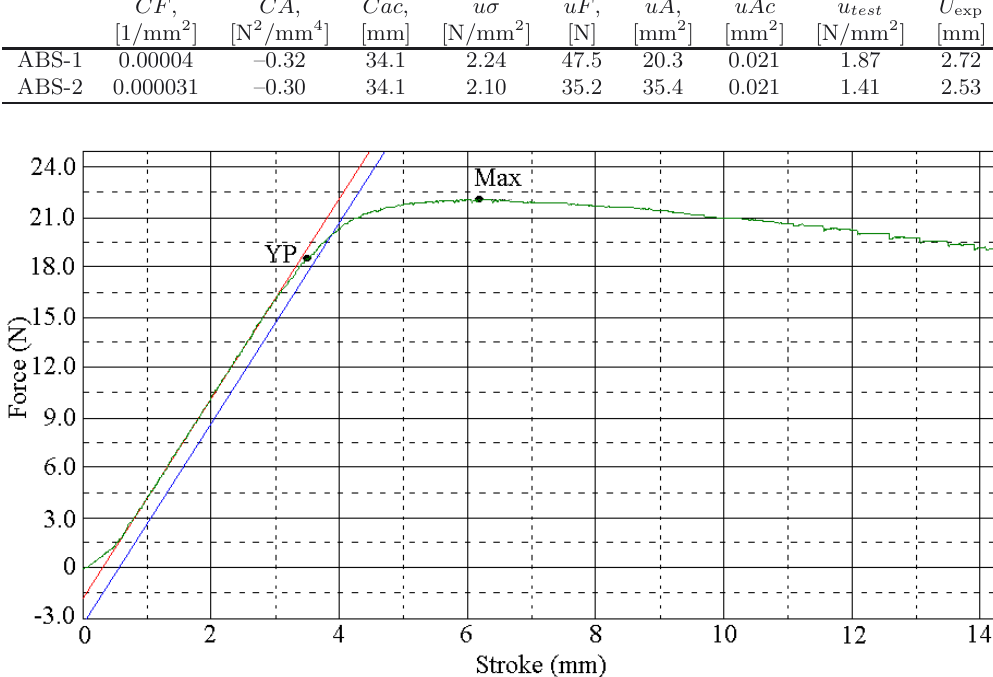
Fig. 5. Strain-stress curves for ABS-2 obtained from